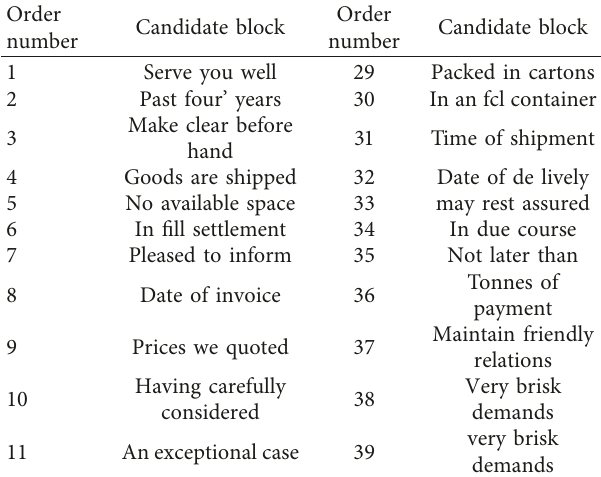
Table 4: Candidate lexical chunks automatically extracted by computer ( N � 3).